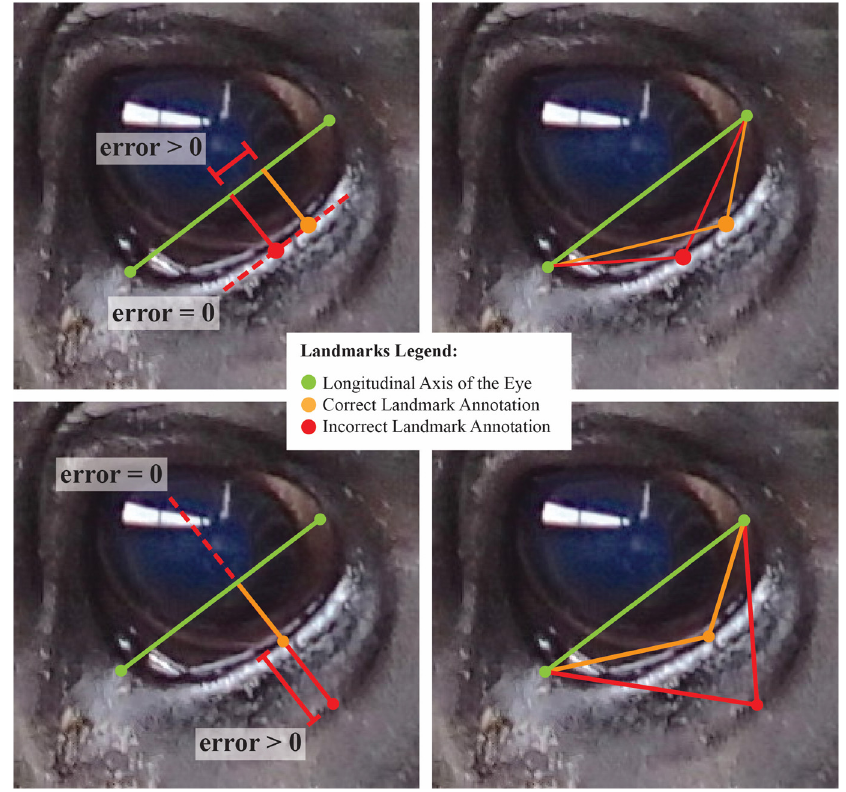
Figure 6. A visualization of changes in normalized length ( right ) and projective biometrics ( left ) with errors in point annotation along the curve of the lower eye. Top photos represent lateral uncertainty in annotation of the maximal point deviation of the curve from the baseline. Bottom photos represent uncertainty in the curve used to place landmark points. In this exaggerated example, these errors in point annotation are isolated to distinct orthogonal projections, but result in synergistic tradeoffs in the Euclidean distances used in calculating normalized length biometrics.